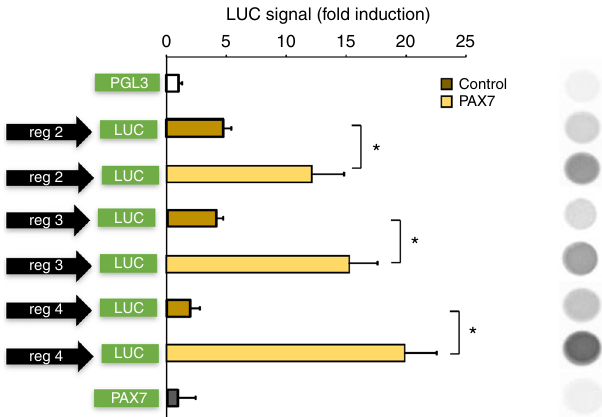
Fig. 4 Luciferase assay in PAX7-transfected HEK293 cells. Relative luciferase activity following transfection of human constructs into HEK293 cells. Cells were co-transfected with the pGL3 promoter vector carrying the construct of interest (regions 2, 3, and 4) cloned upstream of the luciferase gene together with an equimolar amount of plasmid encoding for human PAX7. For the control condition, PAX7 plasmid was replaced with pCDNA3.1. Cells were co-transfected with a β -Gal encoding vector to normalize transfection ef fi ciency and the signal intensity of luciferase. The inset on the right shows a representative chemiluminescent signal emitted from the reaction of luciferase from the different experimental conditions. Data are expressed as the mean ± SEM of four independent